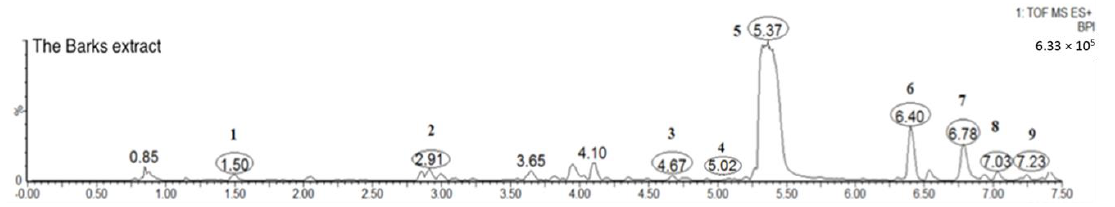
Figure 2. Typical total ion chromatogram of gallic acid (peak 1) and flavonoids (peaks 2 – 9) of the MRB extract.